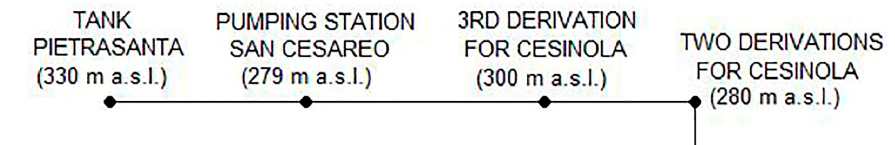
Figure 3. The portion of the “New Aqueduct”, object of pipes